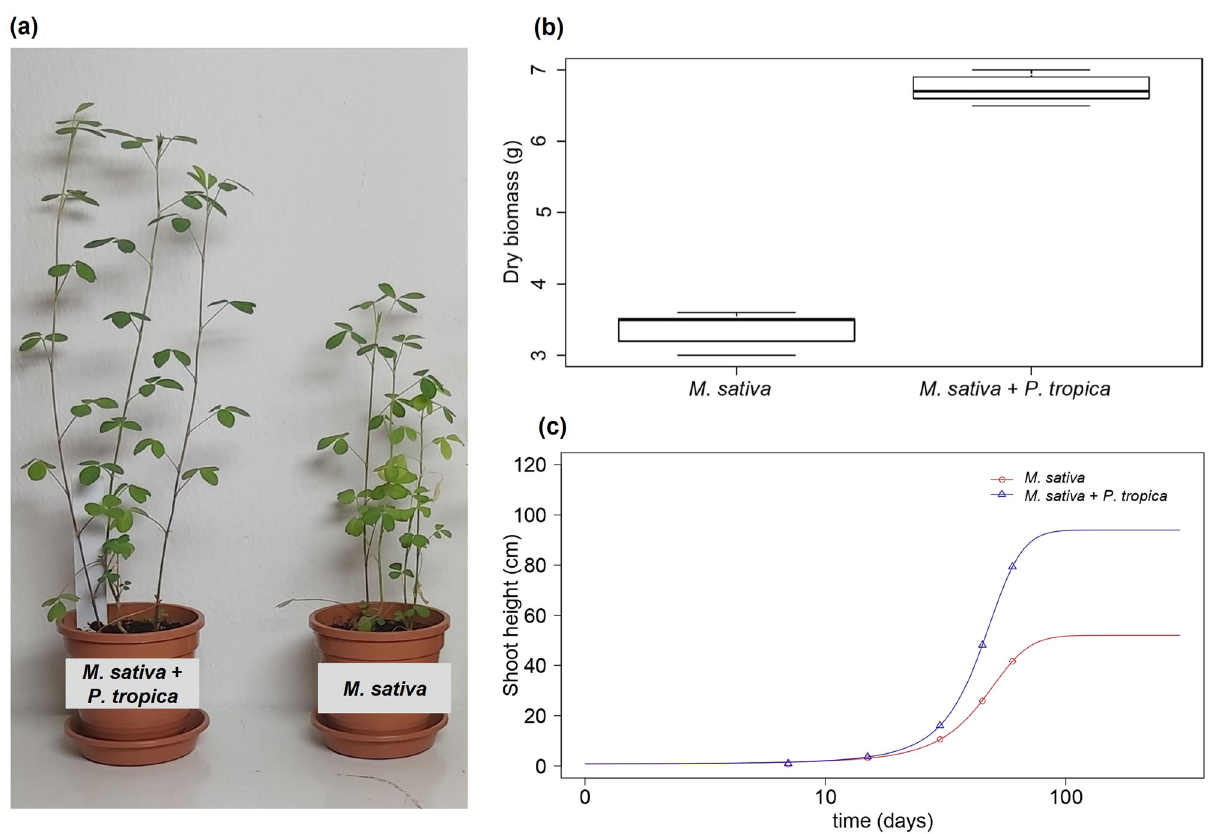
Fig. 1 Effect of bacteria inoculation on plant growth. a Enhancement of growth and biomass production of M. sativa plant by P. tropica inoculation. b Boxplot showing signi fi cant differences in dry biomass of inoculated and uninoculated plants. c 3-parameter logistic model showing differential growth rates (cm/day) of M. sativa inoculated with P. tropica versus uninoculated